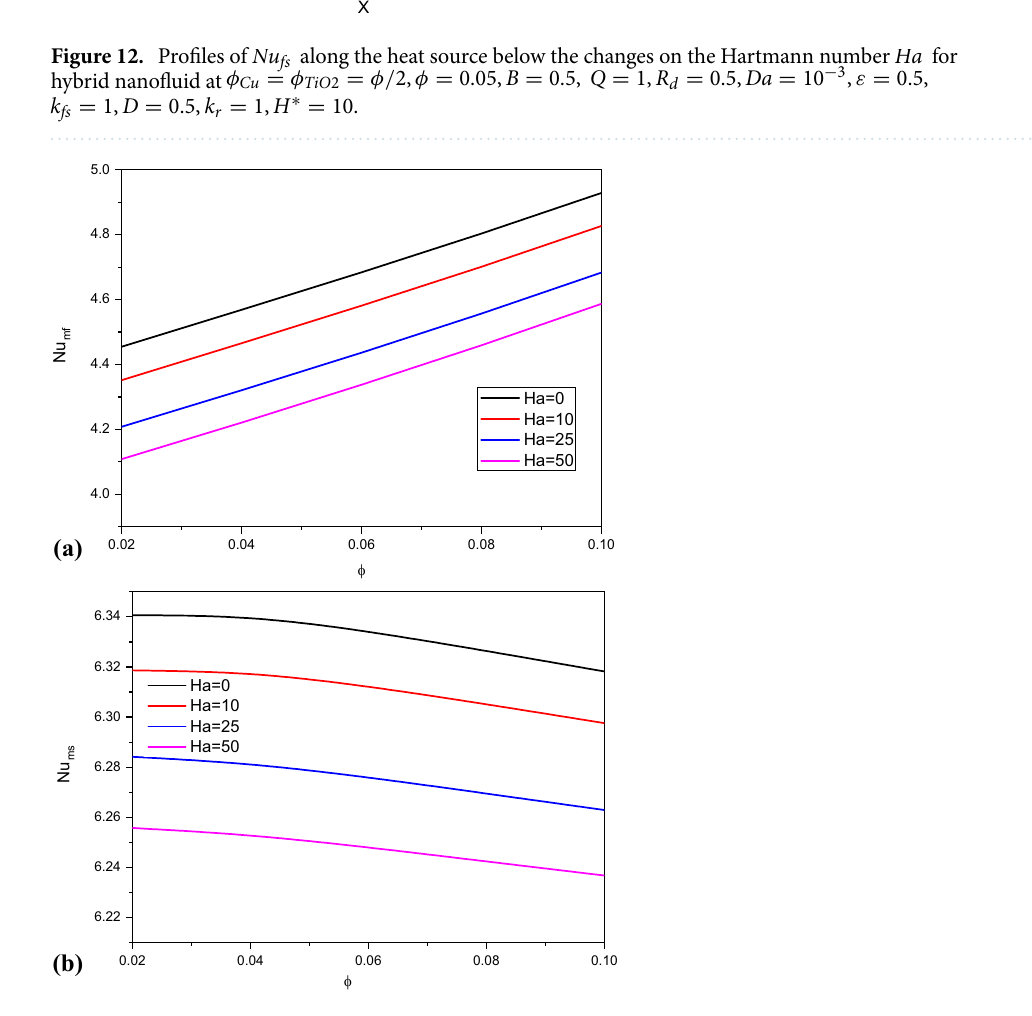
Figure 13. Variation of Nu mf and Nu ms along φ below the changes on the Hartmann number Ha for a hybrid nanofluid at φ Cu = φ TiO 2 = φ/ 2, B = 0.5, Q = 1, R d = 0.5, Da = 10 − 3 , ε = 0.5, k fs = 1, D = 0.5, k r = 1, H ∗ =